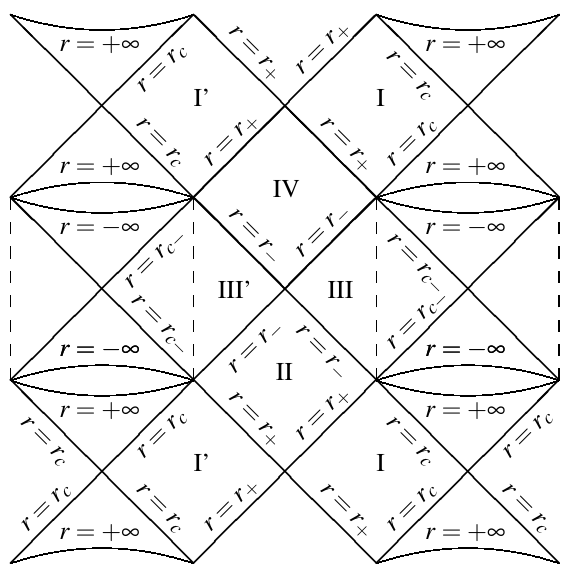
Figure 2. The Penrose–Carter diagram of the maximal Kerr–de Sitter spacetime along the symmetry axis θ = 0. The dashed vertical lines mark where the curvature ring singularities at r = 0 and θ = π /2 occur. For r > 0, there are three horizons: the cosmological horizon r c , the outer black-hole horizon r + and the inner black-hole horizon r . For r < 0, there is another cosmological horizon r c − ∞ are not joined together. The conformal diagram continues ad another infinity. The infinities at r = ± infinitum in all direction